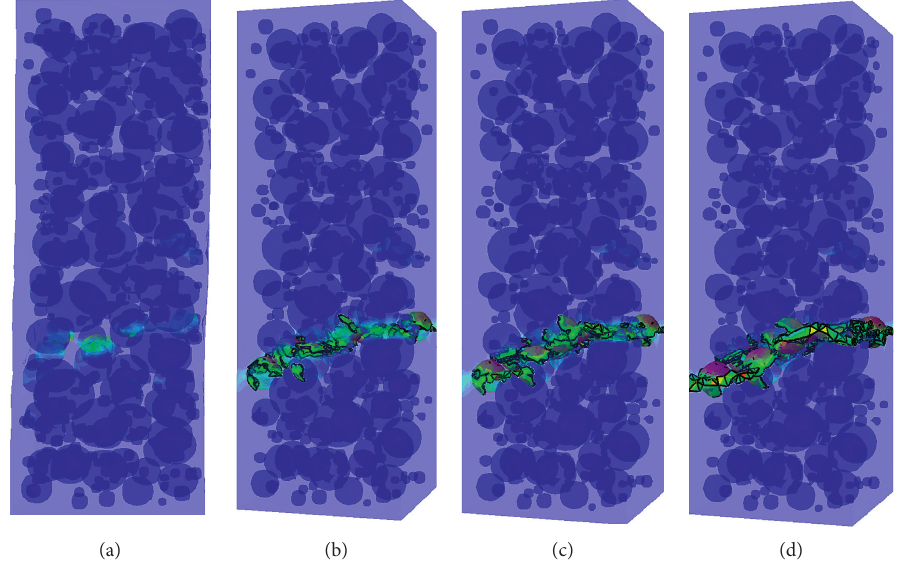
Figure 15: Crack development process of the type I crack ( p is the peak stress; 0 . 8 p , 0 . 6 p , and 0 . 4 p are all corresponding postpeak loading phases). (a) p . (b) 0 . 8 p . (c) 0 . 6 p . (d) 0 . 4 p .